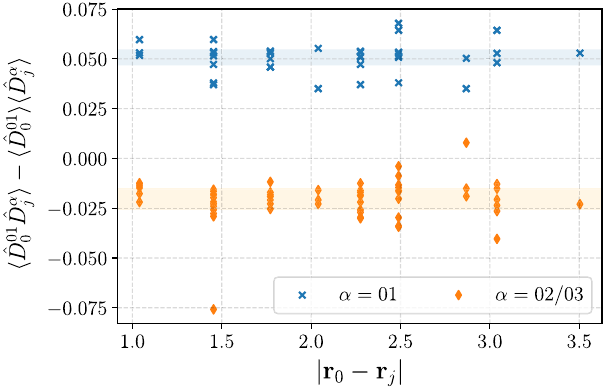
TABLE I. Basis vectors for irreducible representations in the 12-dimensional space of translationally invariant dimer coverings. Here, ω ¼ exp ð 2 π i= 3 Þ . The inversion eigenvalue λ ¼ þ 1 corresponds to g representations, and λ ¼ − 1 corresponds to u representations. The E g = u T g = u a=b=c basis states span the three-dimensional representation. Representation E g = u þ